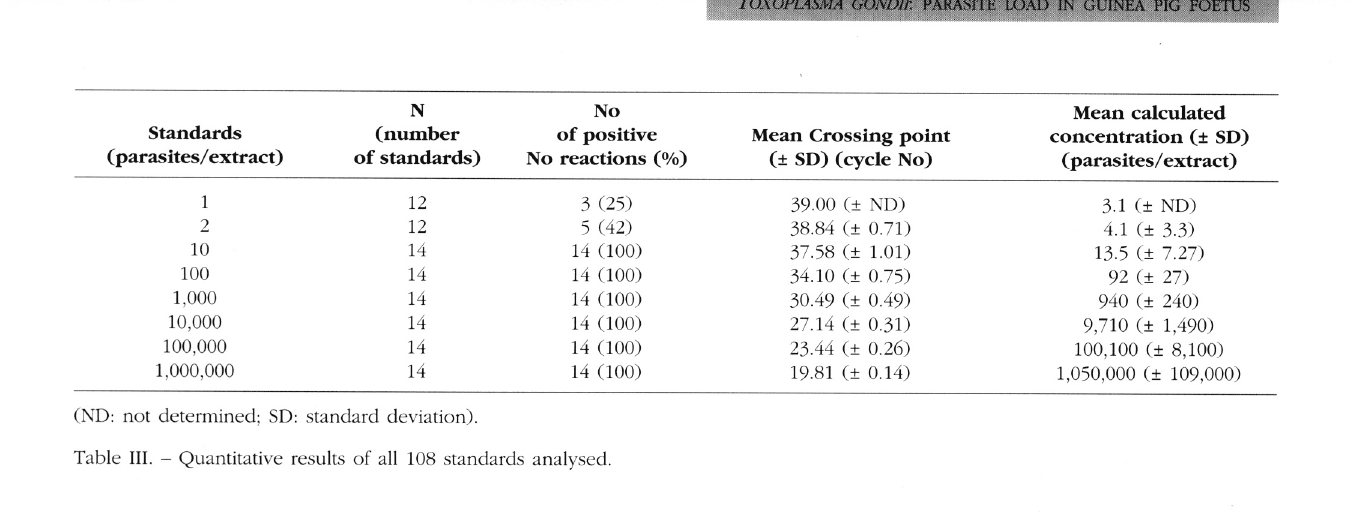
M atern o fo eta l TRANSMISSION OF TOXOPLASMOSIS An offspring was deemed infected when at least one organ (brain, liver, lung or spleen) or when cord blood was positive. It was observed that 84.6 % (11/13) were infected after inoculation at G20 and 100 % (16/16) at G40.